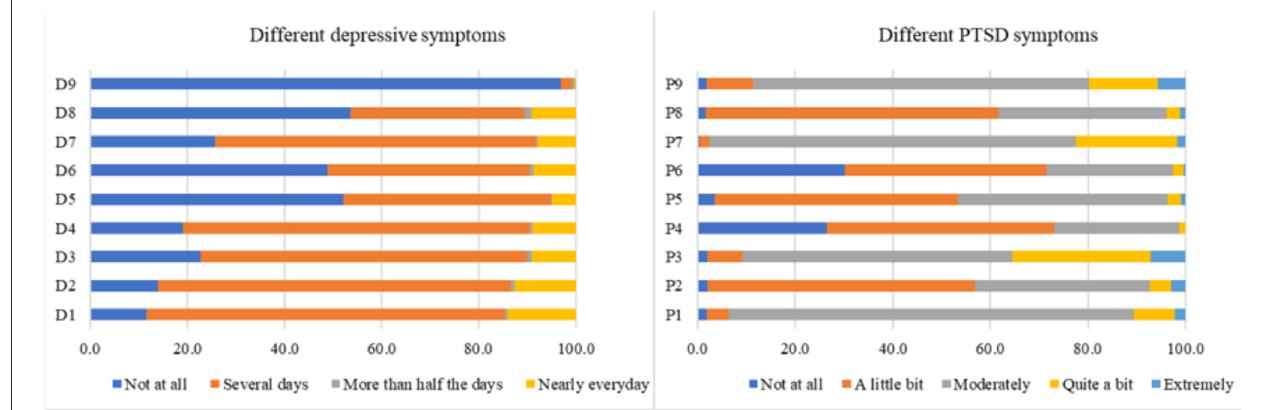
FIGURE 2 | Symptoms of depression and PTSD. D1, Little interest or pleasure in doing things; D2, Feeling down, depressed, or hopeless; D3, Trouble falling or staying asleep, or sleeping too much; D4, Feeling tired or having little energy; D5, Poor appetite or overeating; D6, Feeling bad about yourself or that you are a failure or have let yourself or your family down; D7, Trouble concentrating on things, such as reading the newspaper or watching television; D8, Moving or speaking so slowly that other people could have noticed. Or the opposite being so fidgety or restless that you have been moving around a lot more than usual; D9, Thoughts that you would be better off dead, or of hurting yourself; P1, Having “flashbacks", that is, you suddenly acted or felt as if a stressful experience from the past was happening all over again (for example, you re-experienced parts of a stressful experience by seeing, hearing, smelling, or physically feeling parts of the experience); P2, Feeling very emotionally upset when something reminded you of a stressful experience; P3, Trying to avoid thoughts, feelings, or physical sensations that reminded you of a stressful experience; P4, Thinking that a stressful event happened because you or someone else (who didn’t directly harm you) did something wrong or didn’t do everything possible to prevent it, or because of something about you; P5, Having a very negative emotional state (for example, you were experiencing lots of fear, anger, guilt, shame, or horror) after a stressful experience; P6, Losing interest in activities you used to enjoy before having a stressful experience; P7, Being “super alert", on guard, or constantly on the lookout for danger; P8, Feeling jumpy or easily startled when you hear an unexpected noise; and P9, Being extremely irritable or angry to the point where you yelled at other people, got into fights, or destroyed